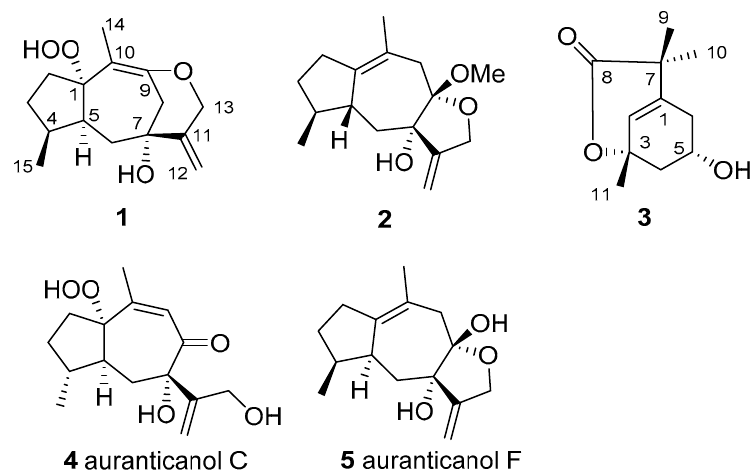
Figure 1. The structures of compounds 1 – 5.